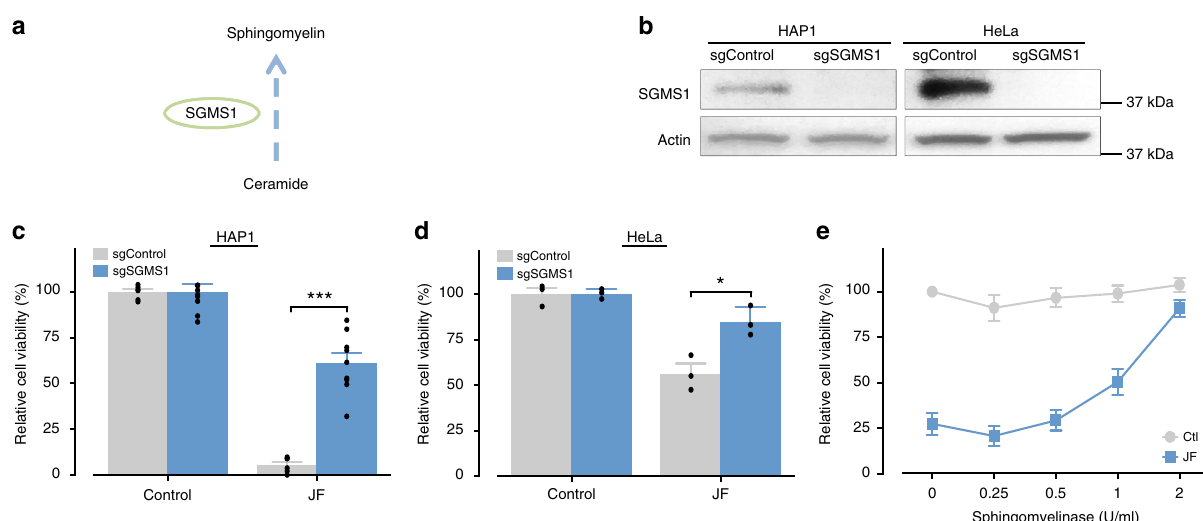
Fig. 5 Sphingomyelin is required for jelly fi sh venom killing. a Schematic representation of SGMS1 in sphingomyelin biosynthesis. b Western blot validation of sgRNA-mediated depletion of SGMS1 in HAP1 and HeLa cells. c , d Depletion of SGMS1 conferring resistance to jelly fi sh venom in c HAP1 (2 µ g/ml; n = 6) and d HeLa cells (1 µ g/ml; n = 3). e The depletion of cellular sphingomyelin reduces jelly fi sh venom-induced cell death. HAP1 cells were pre-treated with the indicated concentration of sphingomyelinase (SMase) for 45 min, washed to remove SMase, and treated with jelly fi sh venom (1 µ g/ml) for 24 h ( n = 3). All data represented as mean ± S.E.M. Student ’ s t -test, * p < 0.05; *** p < screen (Supplementary Table 1). To elucidate this pathway for the jelly fi sh venom cytotoxicity, we generated several CRISPR- knockout lines. Importantly, depletion of key components in the SREBP pathway ( SCAP , MBTPS1 or MBTPS2 ) resulted in genes are required for venom cytotoxicity (Fig. 6b).